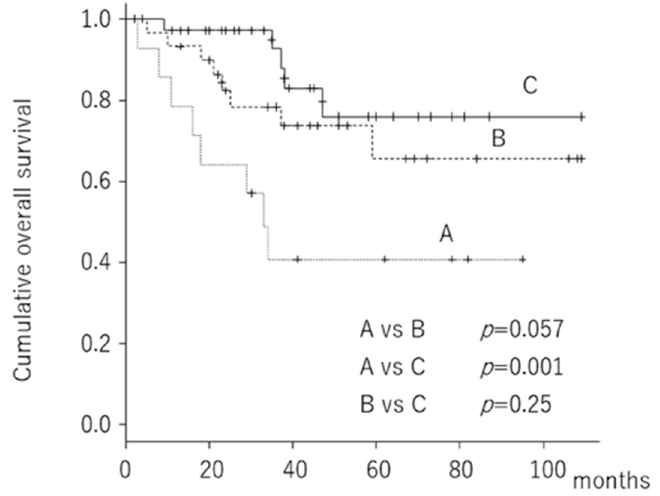
Figure 1. Kaplan–Meier curve showing overall survival according to the expression of IL-6 and IL-6R in the tumor tissue.